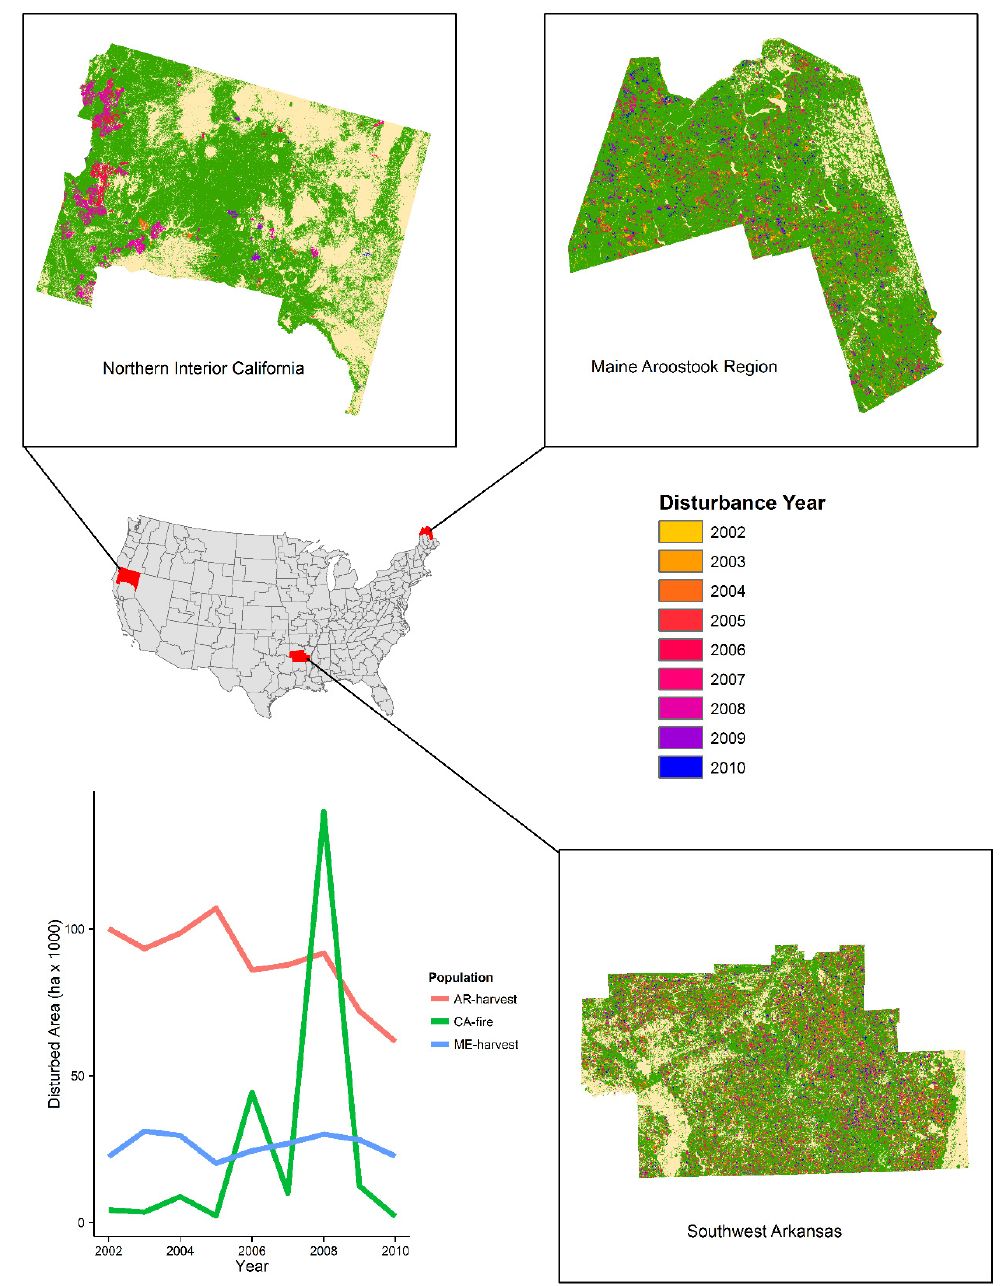
Figure 1. 2002 to 2010 disturbance trajectories for the Arkansas, California, and Maine populations. Each population was sampled based on the FIA hexagonal sampling frame (Bechtold and Patterson 2005), where each hexagon was approximately 2400 ha and contained one sample plot.